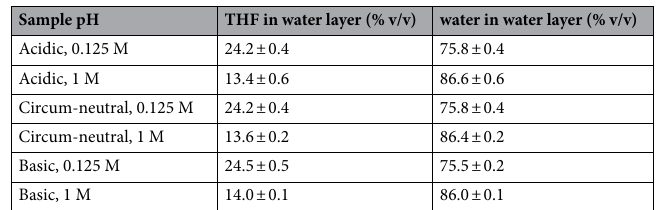
Table 3. 1 H NMR analysis of the water-rich separated layer, obtained starting from 30% v/v THF-70% v/v DI water mixtures, and either 0.125 M or 1 M lauric acid. Samples were centrifuged before analyzing each layer.